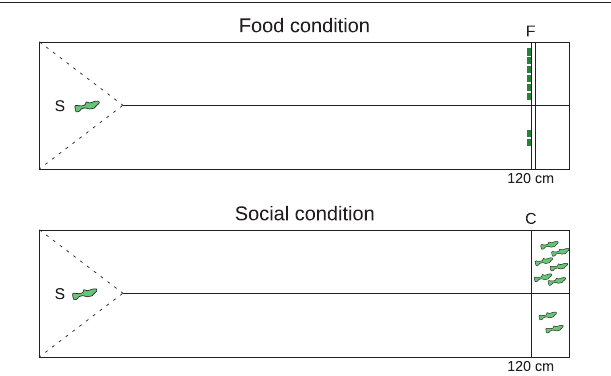
Figure 2 | Visual control task tank, plan view. We presented subjects with a choice between two versus six food items (F, upper panel) or two versus six same-sex conspecifics (C, lower panel). The 160-cm experimental tank was divided lengthwise by an opaque partition (solid line). Subjects remained in a triangular starting space (S) behind a solid, transparent barrier (dashed line) during the intertrial interval. Upon removing the barrier, the subject could swim 120 cm to either the smaller or